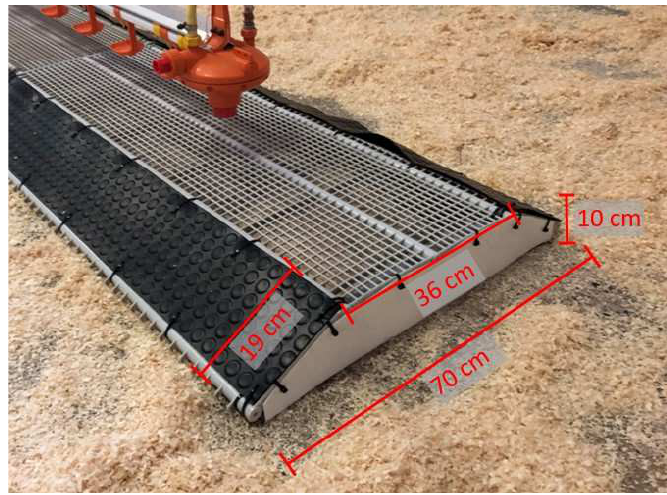
Figure 1. A trapezoid slatted floor.